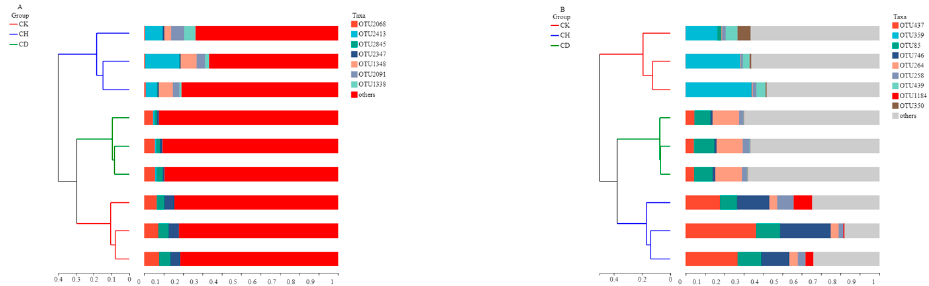
Figure 9. ( A ) NMDS analysis of bacterial community structure. ( B ) NMDS analysis of fungal community structure. CH—biennial ginseng seedlings that were transplanted and then continuously cropped for four years in healthy ginseng rhizosphere woodland soil, CD—biennial ginseng seedlings that were transplanted and then continuously cropped for four years with severe soilborne disease in ginseng rhizosphere woodland soil, CK—soil sample from woodland without ginseng planting.